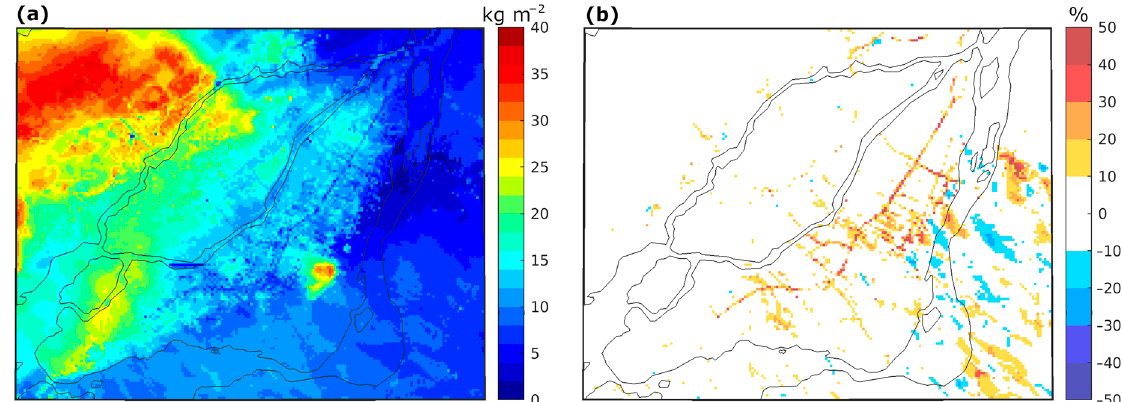
Figure 9. ( a ) Total freezing rain accumulation in the GEM100 simulation. ( b ) Relative difference in freezing rain accumulation between the GEM20 and the GEM100 simulations.